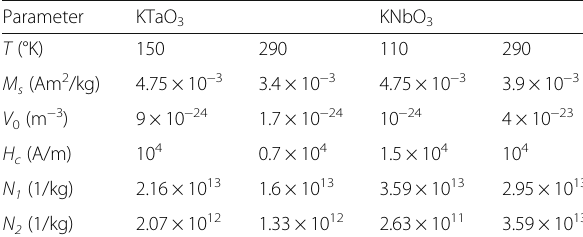
Table 1 Parameters extracted from the fitting of magnetization curves